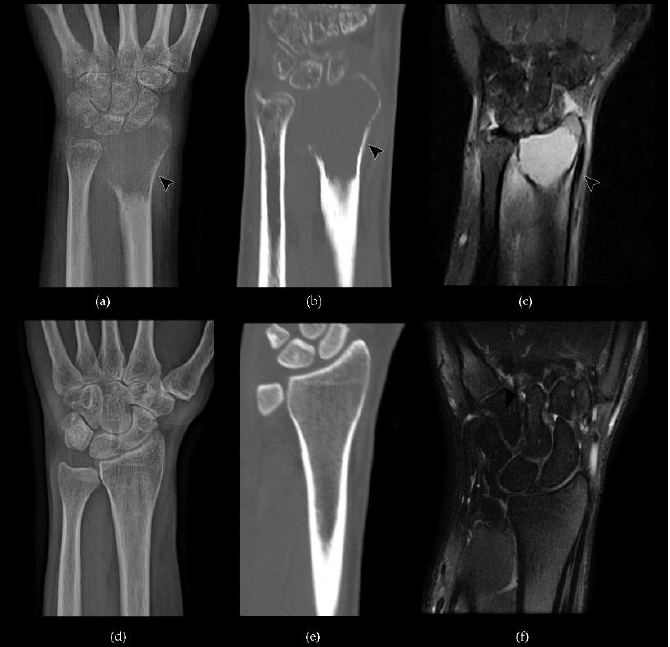
Figure 1. A case of GCTB of the distal metaepiphysis of the right radius with the involvement of the radiocarpal joint ( a – c , arrowhead) compared to normal bone ( d – f ): ( a ) conventional radiography shows an osteolytic lesion with cortical thinning and endosteal scalloping with no periosteal reaction; ( b ) a coronal computed tomography (CT) scan highlights multiple cortical interruptions; ( c ) a coronal STIR magnetic resonance imaging (MRI) sequence shows a lesion with homogeneous signal hyperintensity; ( d – f ) conventional radiography, CT and STIR MR imaging of normal bone findings. On magnetic resonance imaging (MRI), GCTB mostly shows low/intermediate sig- nal in T1-weighted images and high signal in T2-weighted images that can be variably inhomogeneous due to the fibrous components, cystic parts as well as the deposition of hemosiderin within the tumor [62,63]. Hemosidenin foci represent a hyperaccumulation of iron due to extravasated erythrocytes phagocytosis from both mononuclear stromal cells and multinucleated giant cells